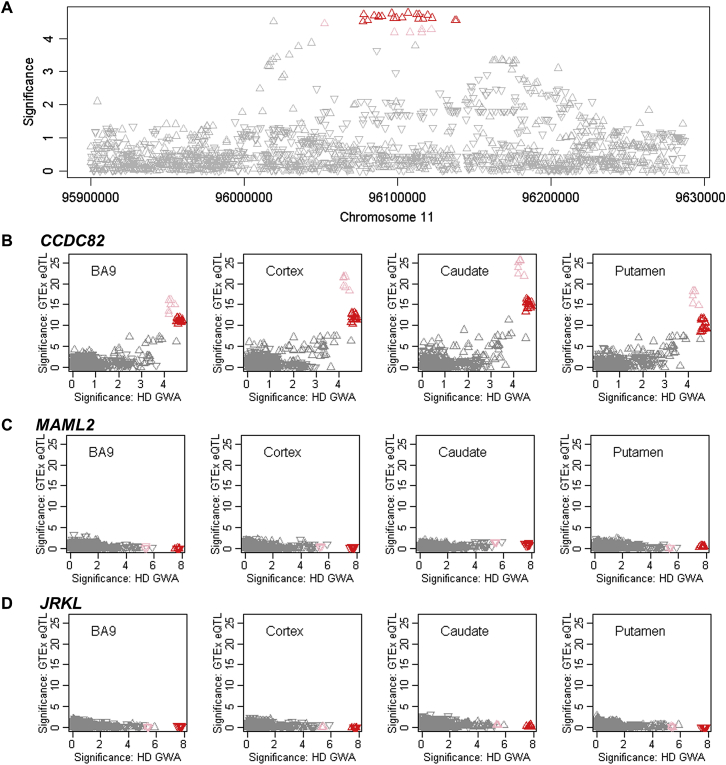
Association Signals in Continuous Phenotype Analysis for Chromosome 11 Region and Correspondence to GTEx eQTL Signals, Related to Figure 6(A) Association analysis for SNPs in the chromosome 11 region using the continuous phenotype. (B). These continuous phenotype analysis results were compared to GTEx eQTL signals for CCDC82 in brain regions.(C and D) GTEx eQTL signals for MAML2 (C) and JRKL (D) in selected brain regions (y axis) were compared to chromosome 11 onset modifier signals based on the dichotomous phenotype (from Figure 6). Red and pink triangles represent SNPs marking the 11AM1 and a closely related haplotype.